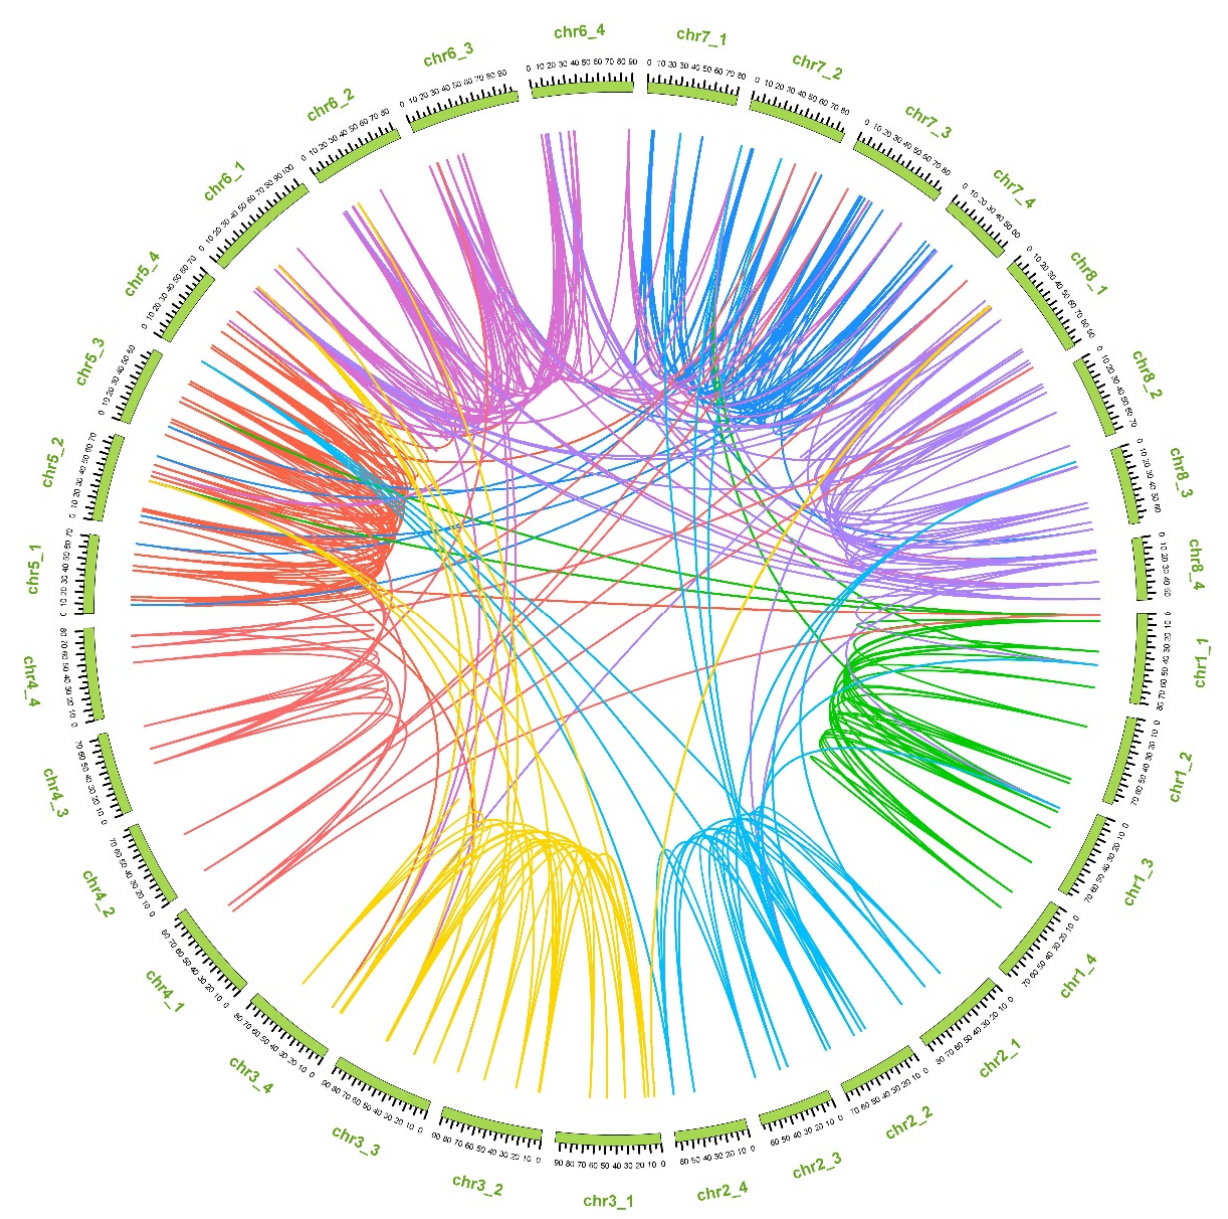
Figure 3. Synteny analysis of the UGT genes of alfalfa. Chromosomes are shown in the outer circle in green. Eight different color lines inside indicate duplicated MsUGT gene pairs in 8 chromosomes.